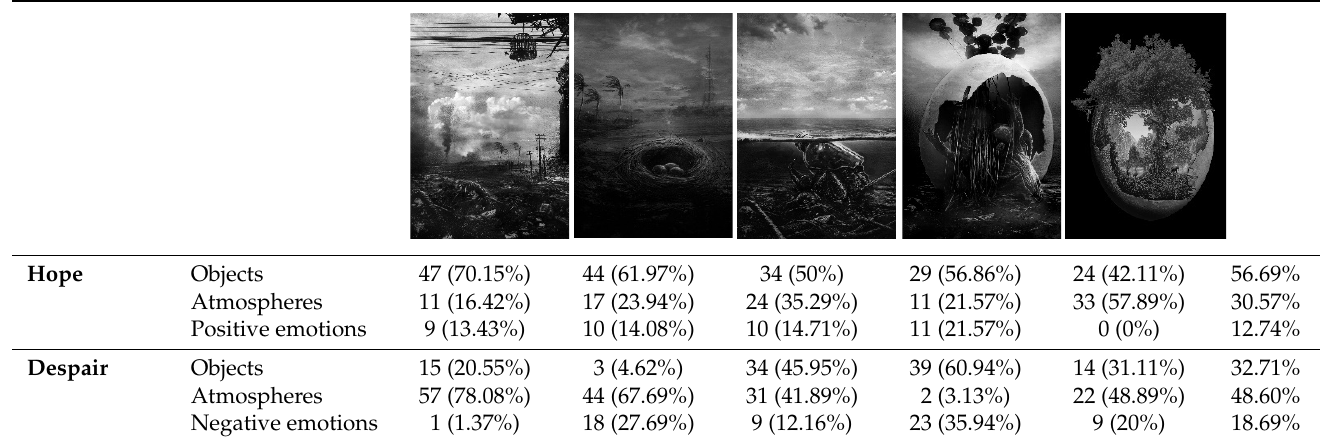
Table 9. Percentage of objects, atmospheres, and emotions on black-and-white images expressing hope and